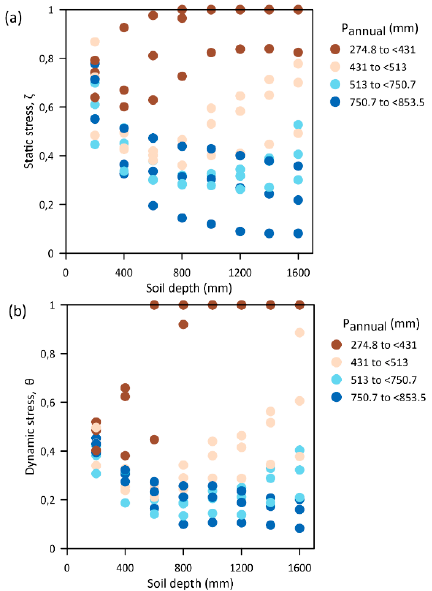
Figure 7. Sensitivity of the ( a ) static and ( b ) dynamic stress to soil depth. Color codes show the annual precipitation classified into four levels.